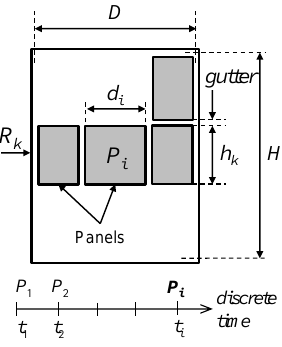
Fig. 3. Elements of a comic book page of size D x H , where the panel P i is within row R k and has a size of d i x h k